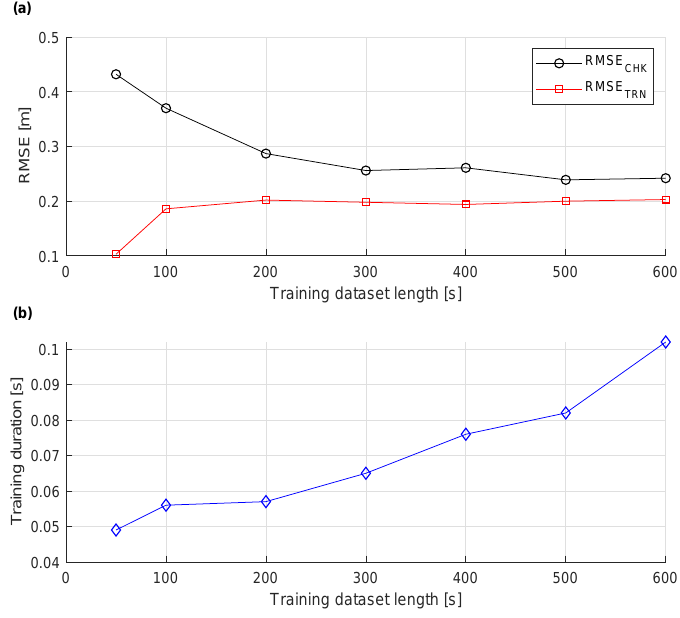
Figure 6. The relationship between length of training dataset and checking error RMSE CHK , and training error RMSE TRN ( a ) and training duration ( b